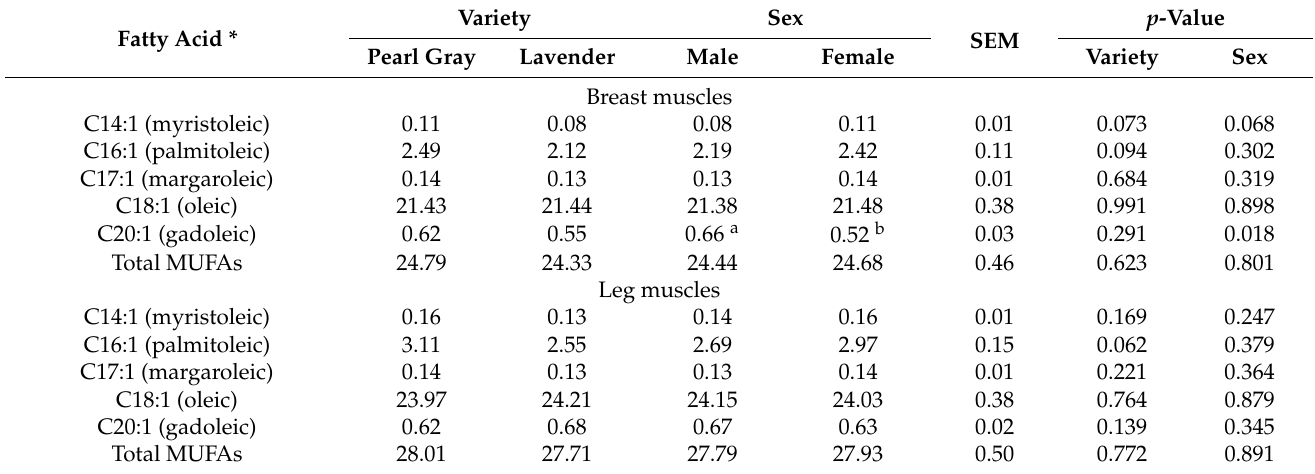
Table 7. Proportions (%) of monounsaturated fatty acids in the total fatty acid pool in the intramuscu- lar fat (breast and leg muscles) of female and male guinea fowl of pearl gray and lavender varieties (means ± SEM).